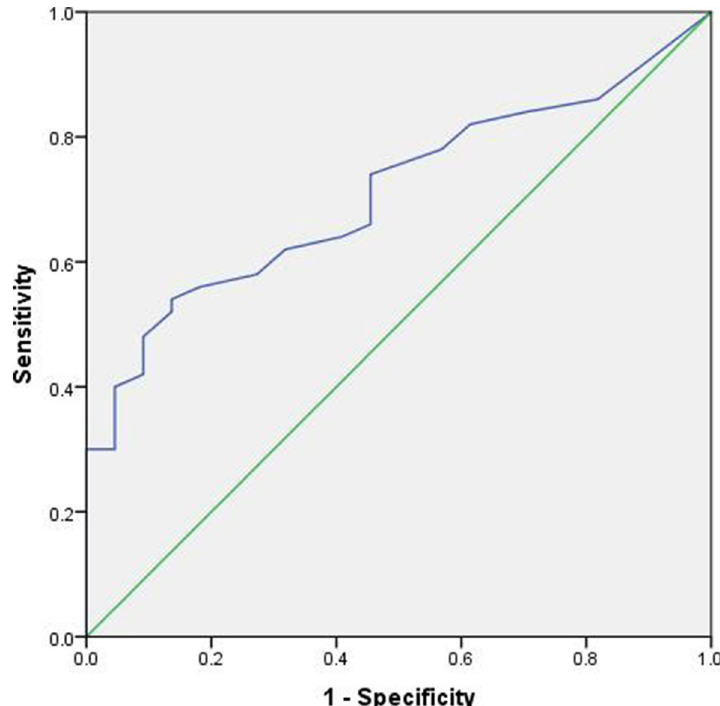
Fig. 2 The ROC curve analysis for the diagnostic values of mTGF‑ß1on CD4 subjects. ROC curve identified an optimal cutoff value of